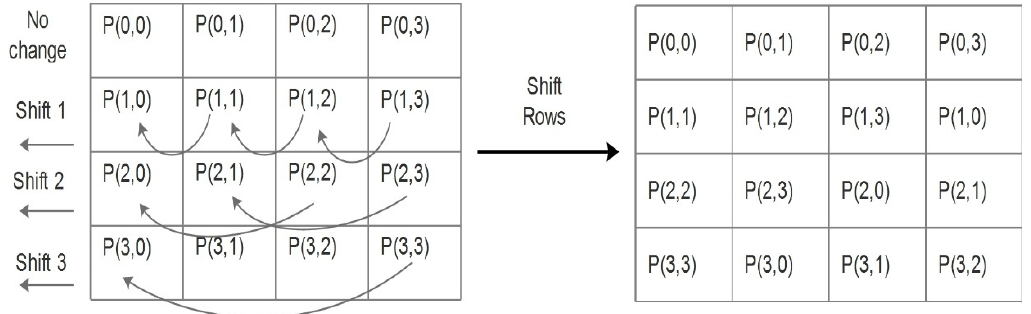
Figure 3. Shift rows transformation.